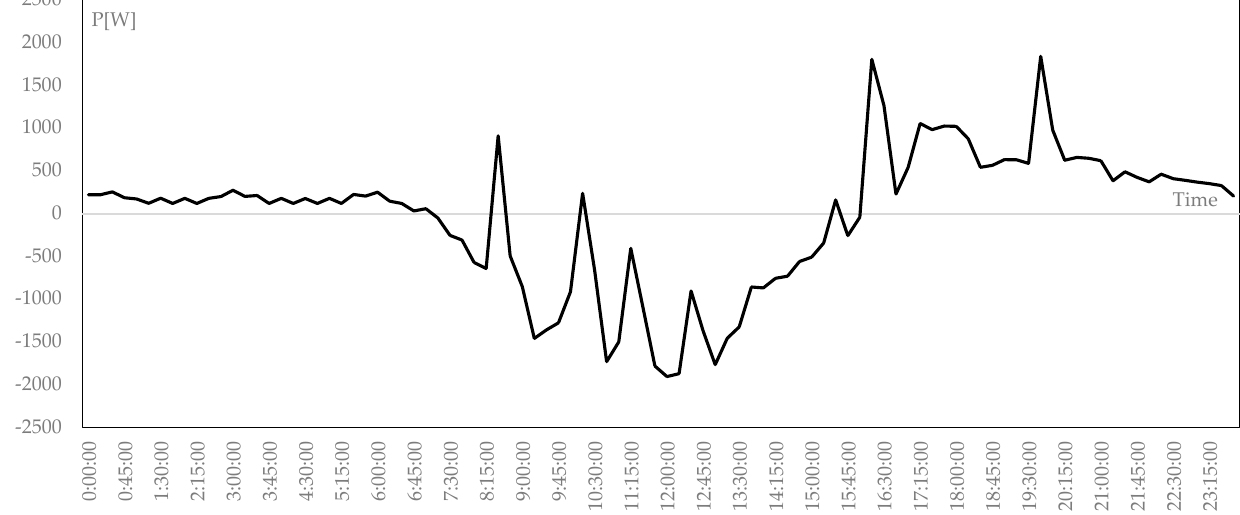
Figure 16. Exchanged power with the grid without the use of the DCNG.